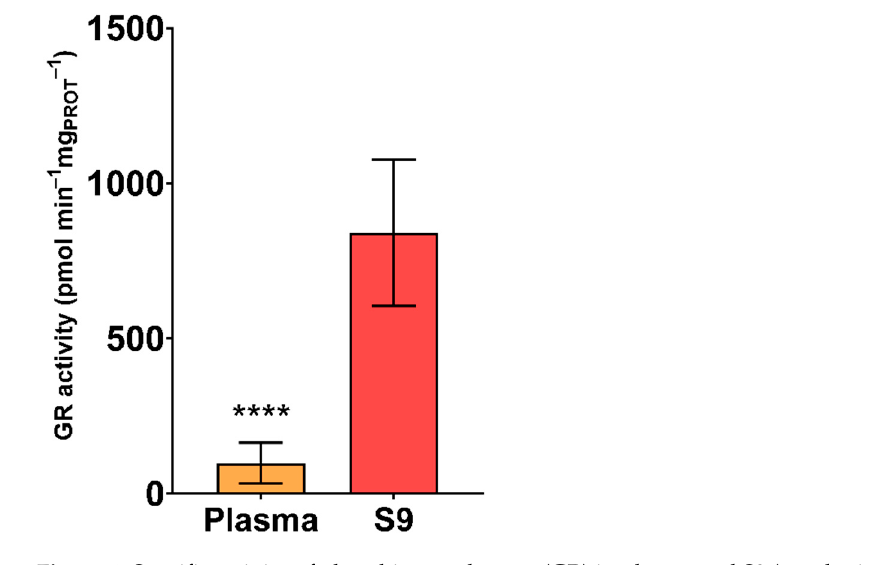
Figure 4. Specific activity of glutathione reductase (GR) in plasma and S9 (pmol min − 1 mg PROT − 1 ) of white stork ( C. ciconia ) nestlings ( n = 16), presented as the mean ± SD. Statistical difference is indicated with **** (Welch’s t-test, p < 0.0001).